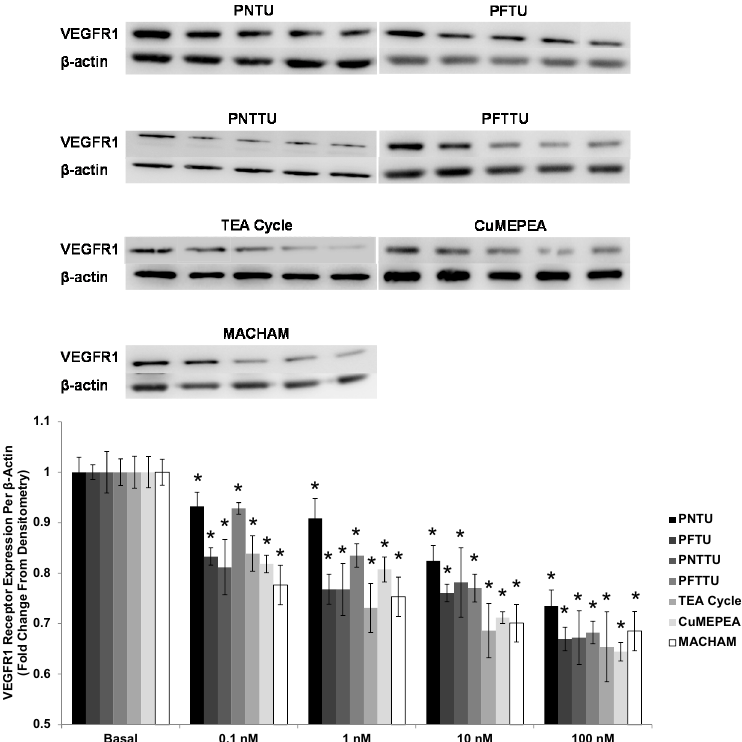
Figure 6. CTB cells were treated with different concentrations of SRs, and Vascular endothelial growth factor receptor 1 (VEGFR1) receptor expression was measured in the cell lysates by Western Blot. The SRs significantly (* p < 0.05) downregulated the expression of VEGFR1 receptor in CTB cells. The data are presented as mean ± SEM for four experiments. One blot from each of the seven SRs is shown.